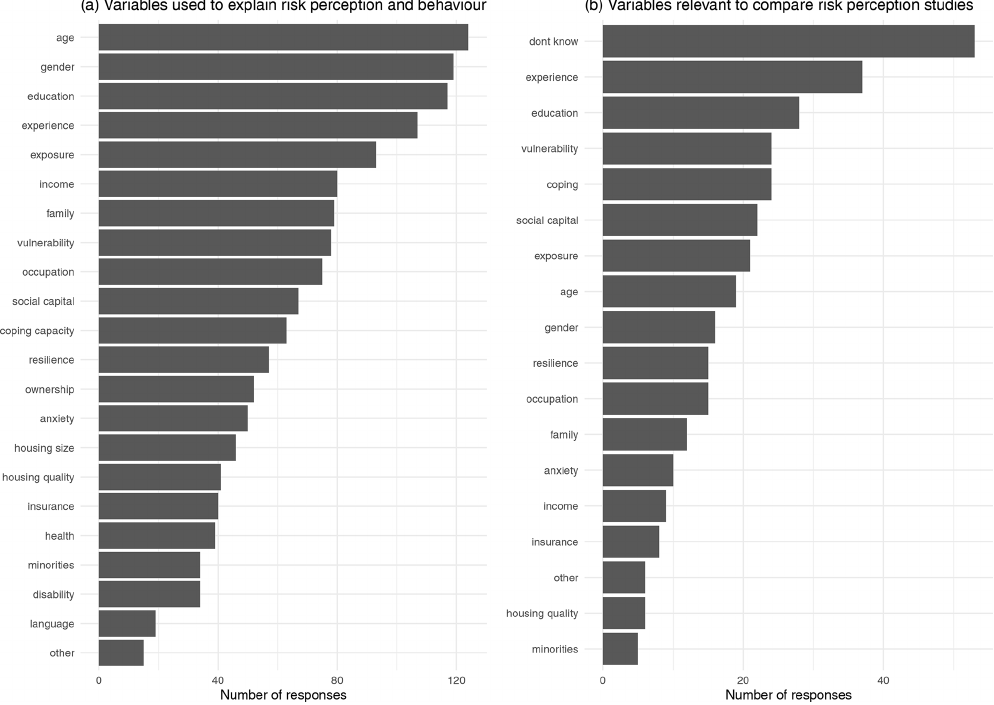
Figure 8. The most used variables to explain risk perception and behaviour (a) and variables (three choices) identified as most relevant for cross-study comparability and long-term monitoring (b)